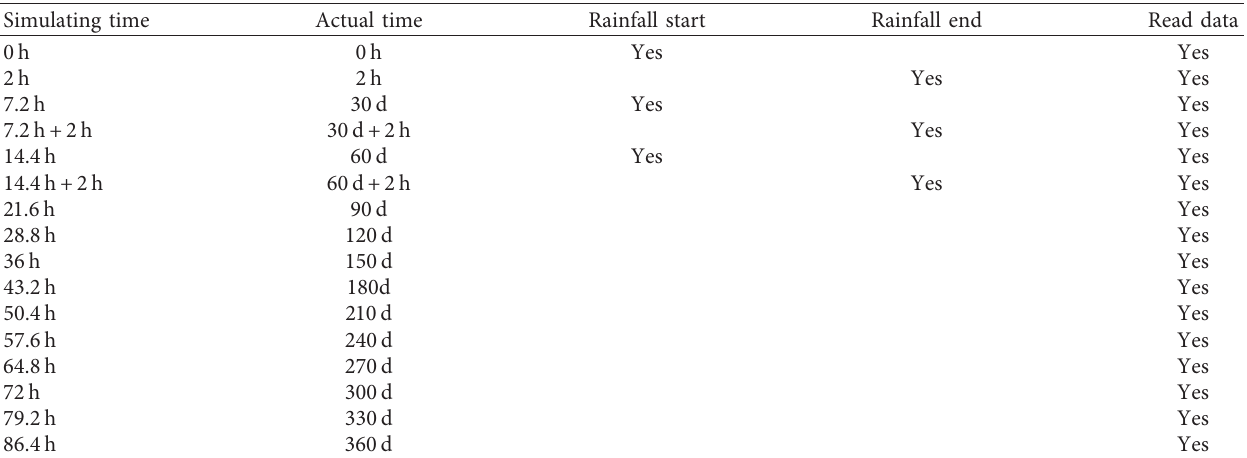
Figure 7: Full dimensions of model slope and layout of measurement points. Table 3: The rainfall